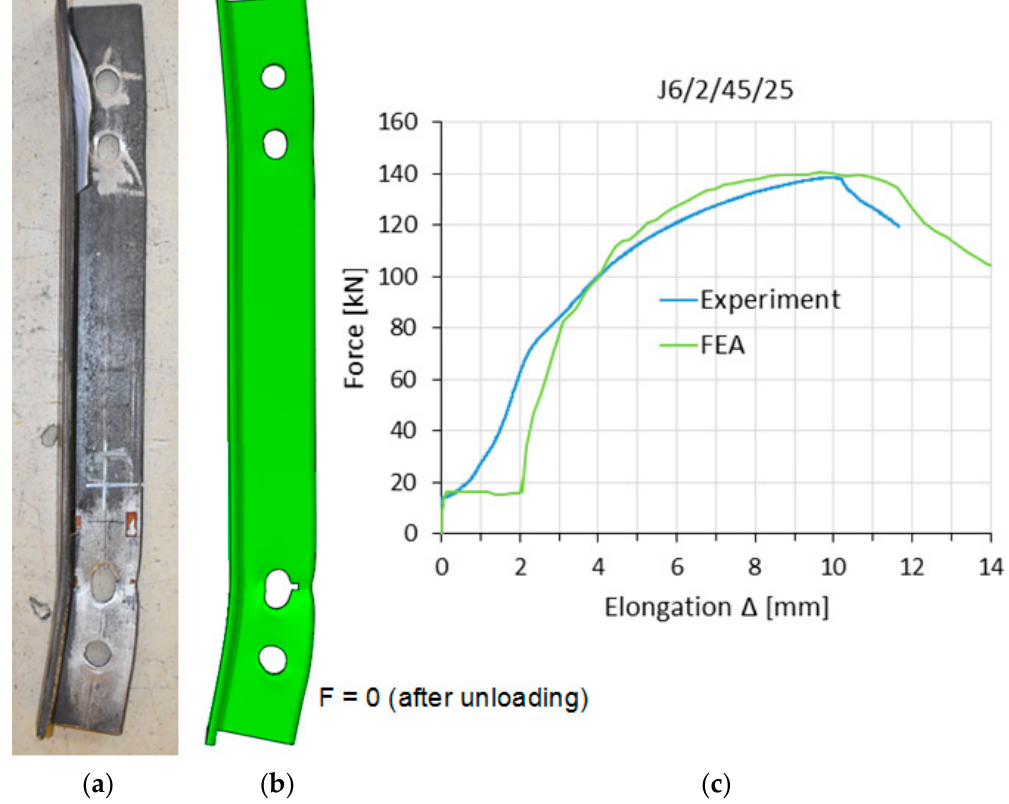
Figure 8. Specimen J6/2/45/25 after fracture: ( a ) experiment, ( b ) FEA model, ( c ) F– Δ curves.